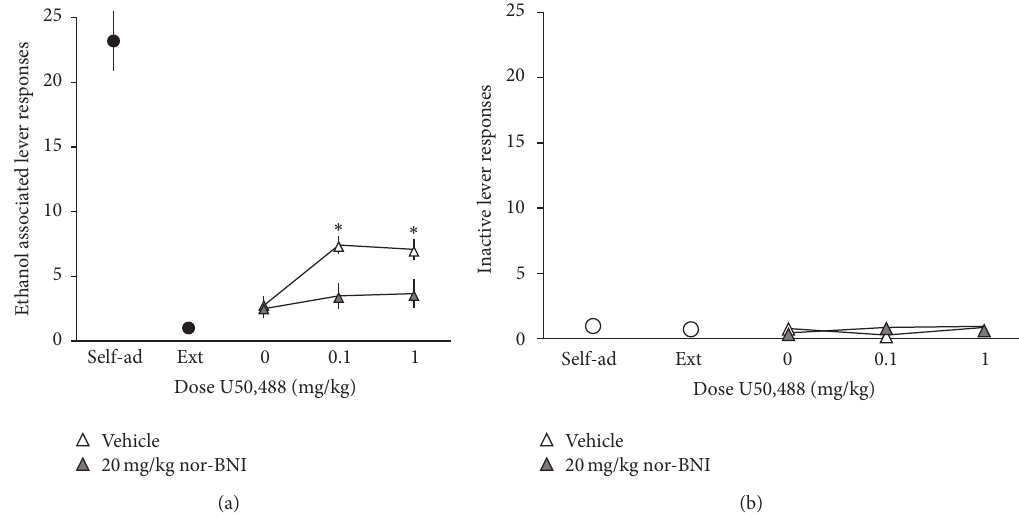
Figure 5: (a) nor-BNI attenuates U50,488-induced reinstatement of ethanol seeking. Rats ( 𝑛 = 12 ) were trained to self-administer a 10% ethanol solution using standard operant procedures, and then lever pressing for ethanol was subsequently extinguished. Following extinction, rats were pretreated with saline 24 h prior to reinstatement testing. Prior to testing, rats received priming injections of U50,488 (0–1.0 mg/kg, i.p.) and were tested for reinstatement of responding on the previously ethanol-associated lever. Over the next 6–8 days, test sessions were repeated every 3-4 days with rats experiencing extinction sessions daily between test days, and doses of U50,488 were given in an irregular order. After all doses of U50,488 were tested, rats were injected with the KOR antagonist nor-BNI (20 mg/kg, i.p.). 24 h later, rats were injected with a priming dose of U50,488 (0.1–1.0mg/kg, i.p.) or saline prior to testing. Over the next 6–8 days, test sessions were repeated as described. Data are expressed as the mean number of lever responses ± SEM during ethanol self-administration sessions. ∗ 𝑝 < 0.05 compared to saline- injected rats receiving the same dose of U50,488, Sidak’s test for multiple comparisons. (b) Responding on an inactive lever was measured as an indication of general motor activity. No effects on inactive lever responding were